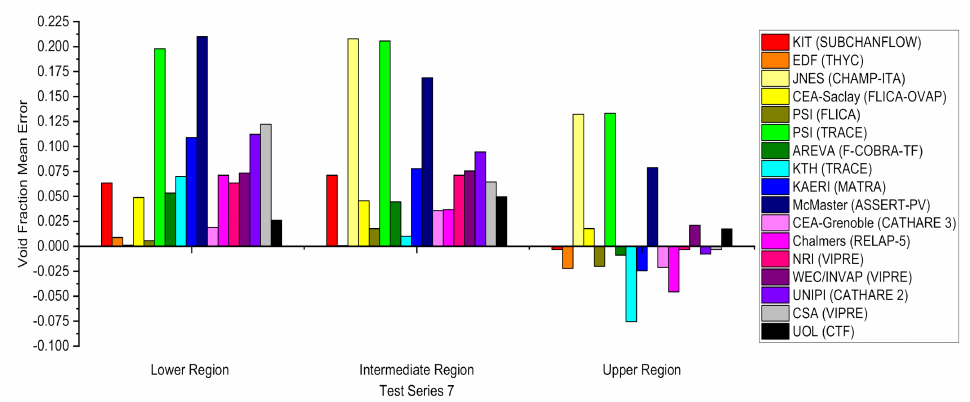
Figure 7. Codes void fraction mean